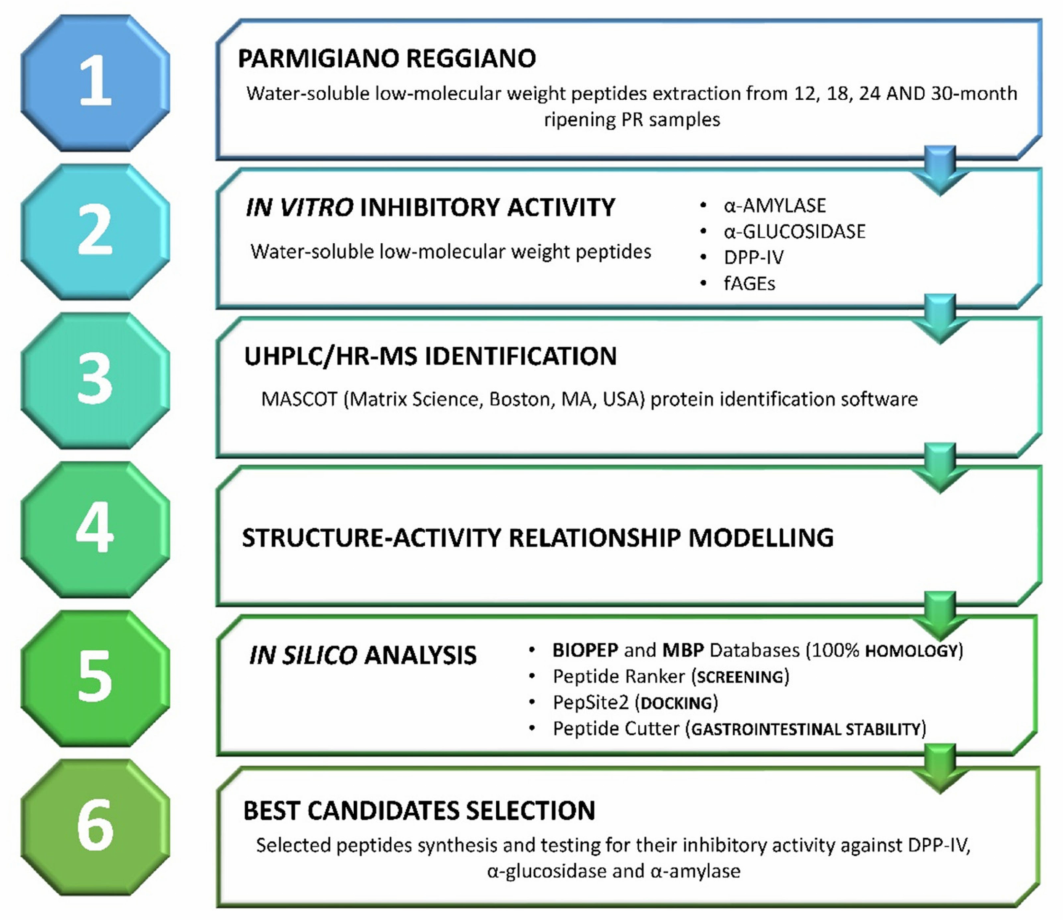
Figure 1. Graphical summary of the proposed study design. The different steps of the present study are summed up to provide an easy and quick overall view of the methodological approach. PR: Parmigiano-Reggiano; DPP-IV: dipeptidyl peptidase IV; fAGEs: fluorescent advanced glycation